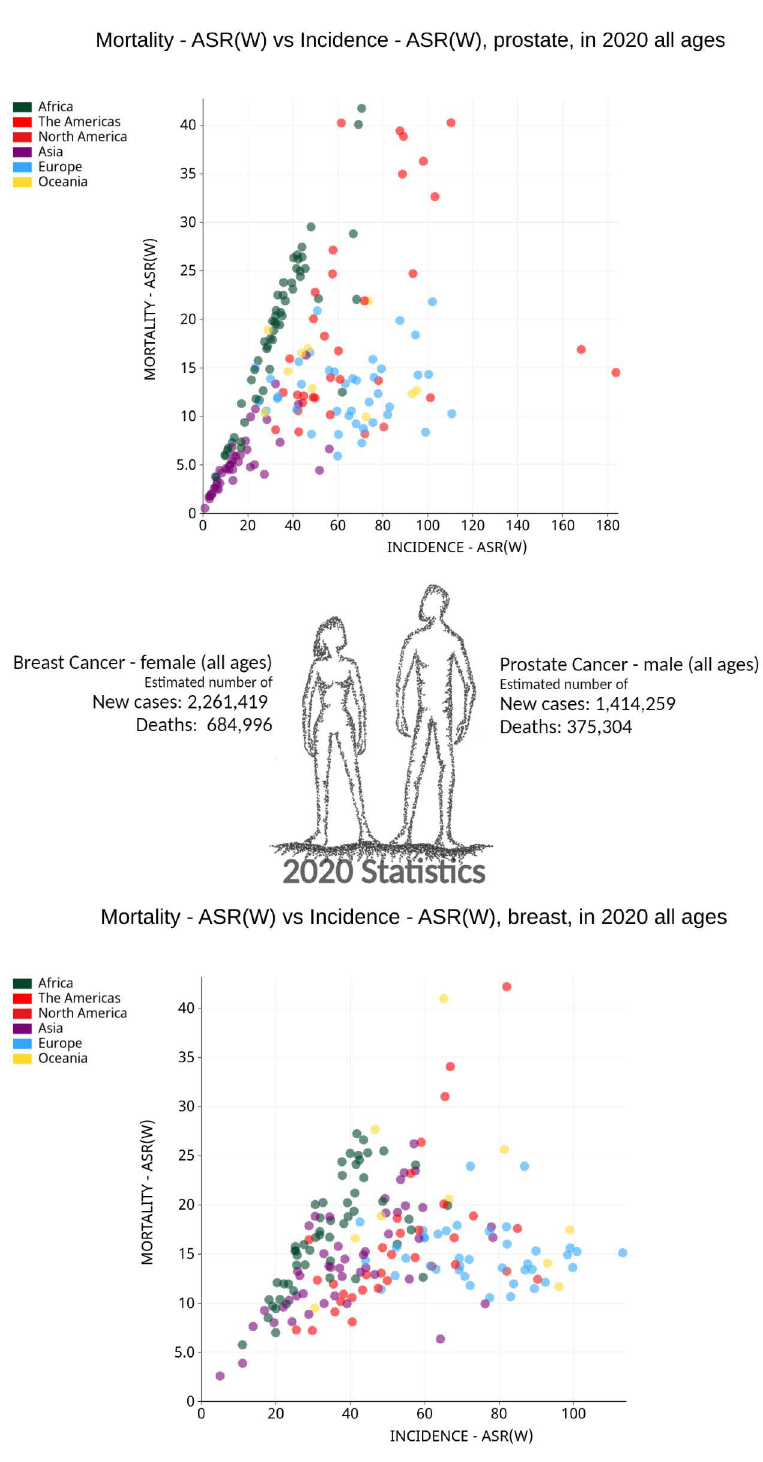
Figure 2. 2020 Global breast and prostate cancer statistics for women and men: Estimated number of new cases and deaths for both sexes including all ages. The top graph represents prostate cancer and bottom graph represents breast cancer: age standardized rates (ASR) based estimated new cases and deaths as reported by Global Cancer Observatory (GCO). Both breast and prostate cancer are among the leading cancers contributing to both new cases and deaths in women and men. Figures taken from IARC website (https://gco.iarc.fr/today, accessed on 20 November 2021)